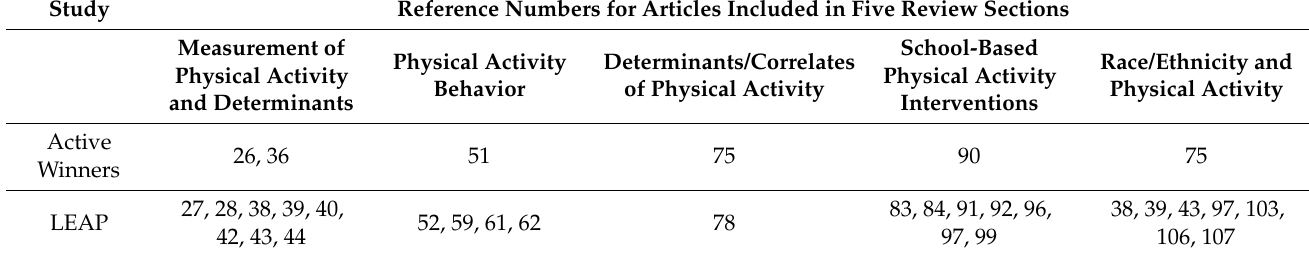
Table 3. Articles Referenced in Each Review Section by